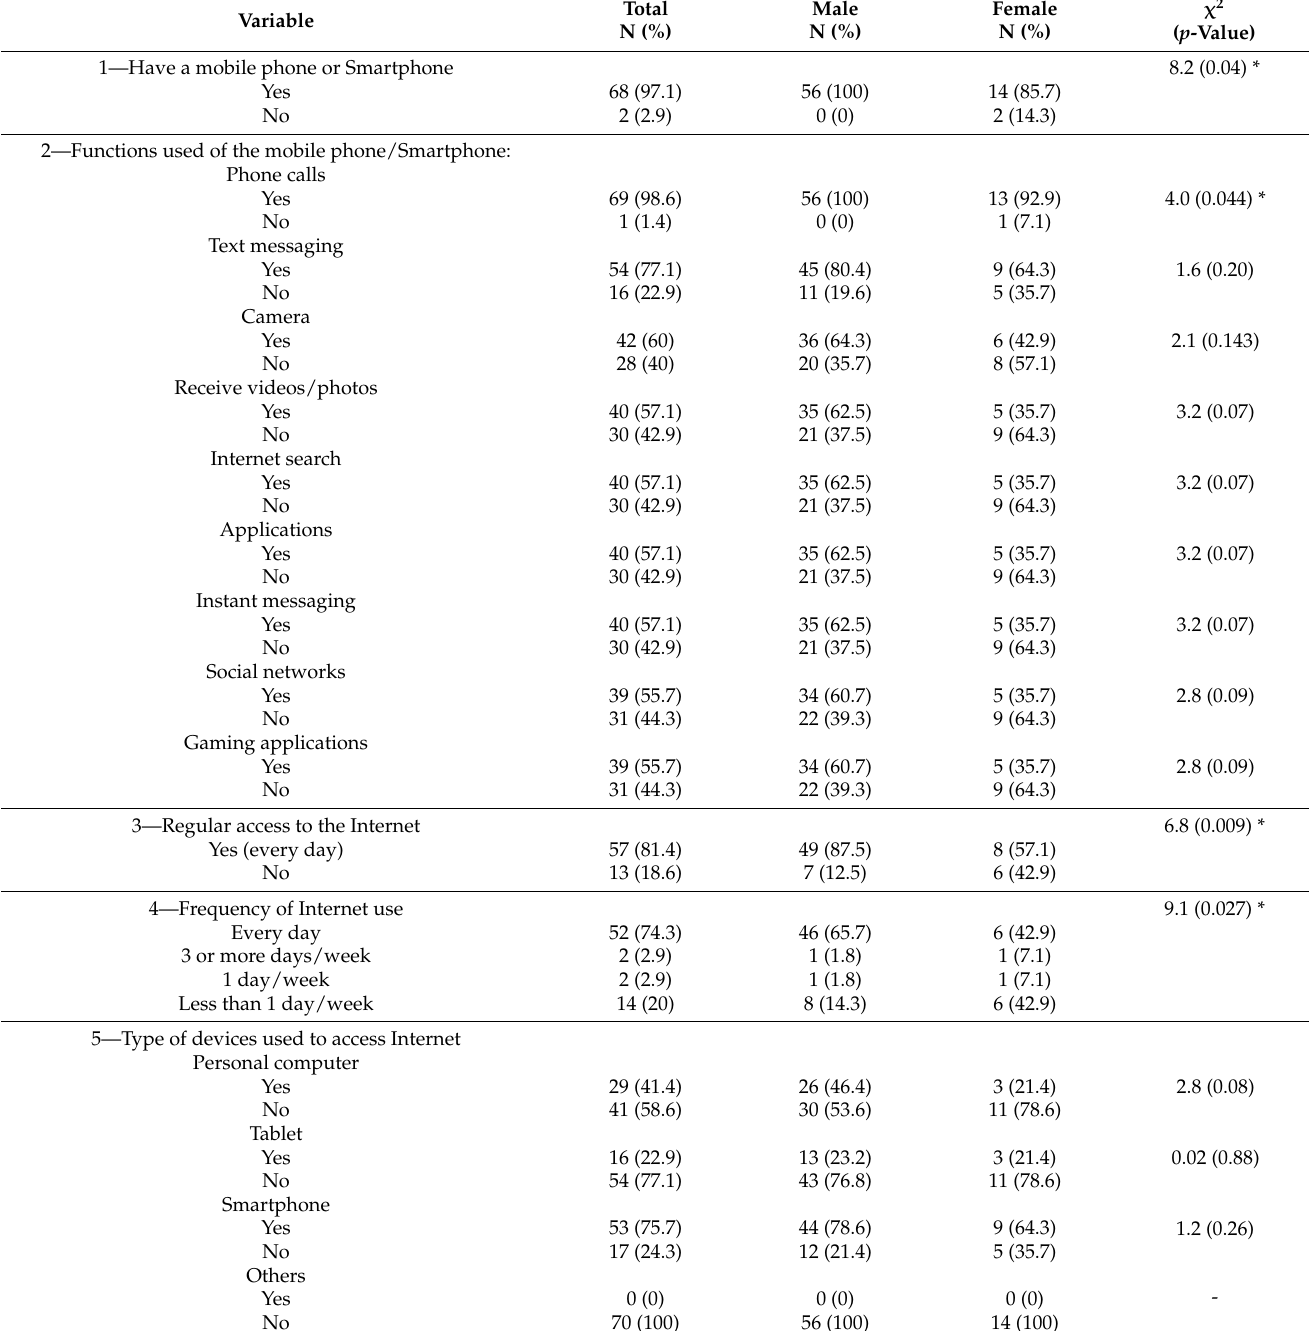
Table 2. Comparison of technology usage of older adults by